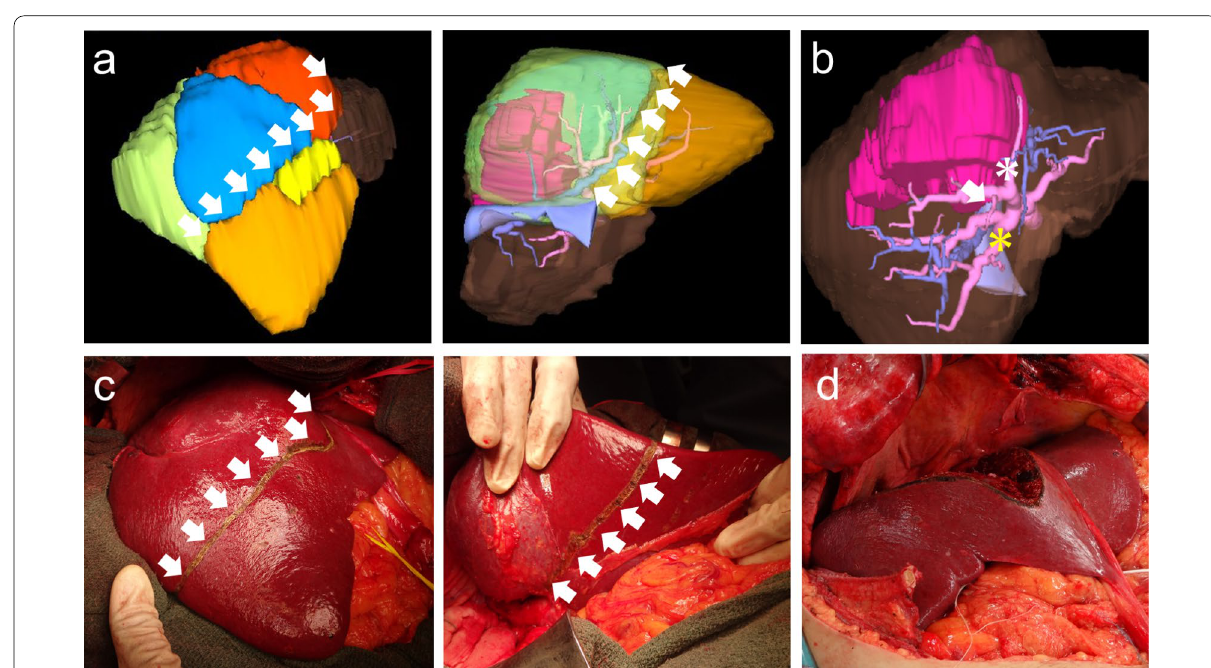
Fig. 2 Determination of the transection line and liver resection. a (Left) 3D CT imaging of segment 5 (yellow), segment 6 (orange), segment 7 (green), the dorsal portion of segment 8 (blue), and the ventral portion of segment 8 (red). (Right) 3D CT imaging on the backside. The white arrows show the planned resection line. b 3D CT imaging of P5 (white arrow), dorsal P8 (white asterisk), and P6 (yellow asterisk). c The resection line was marked according to the demarcation line after portal staining. Left, frontside. Right, backside. d The resection surface of the remnant liver. 3D CT, three-dimensional computed